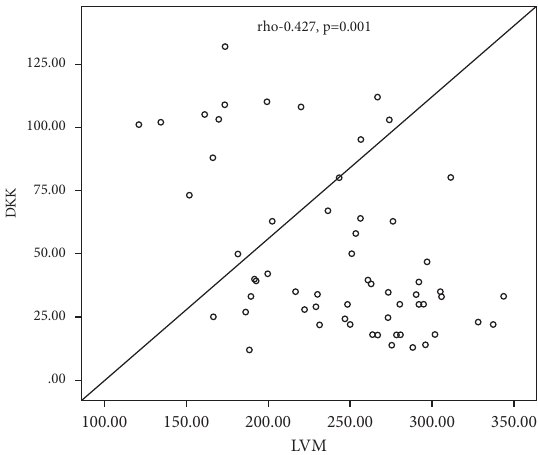
Figure 2: Linear negative correlation between the left ventricular mass and serum Dickkopf-related